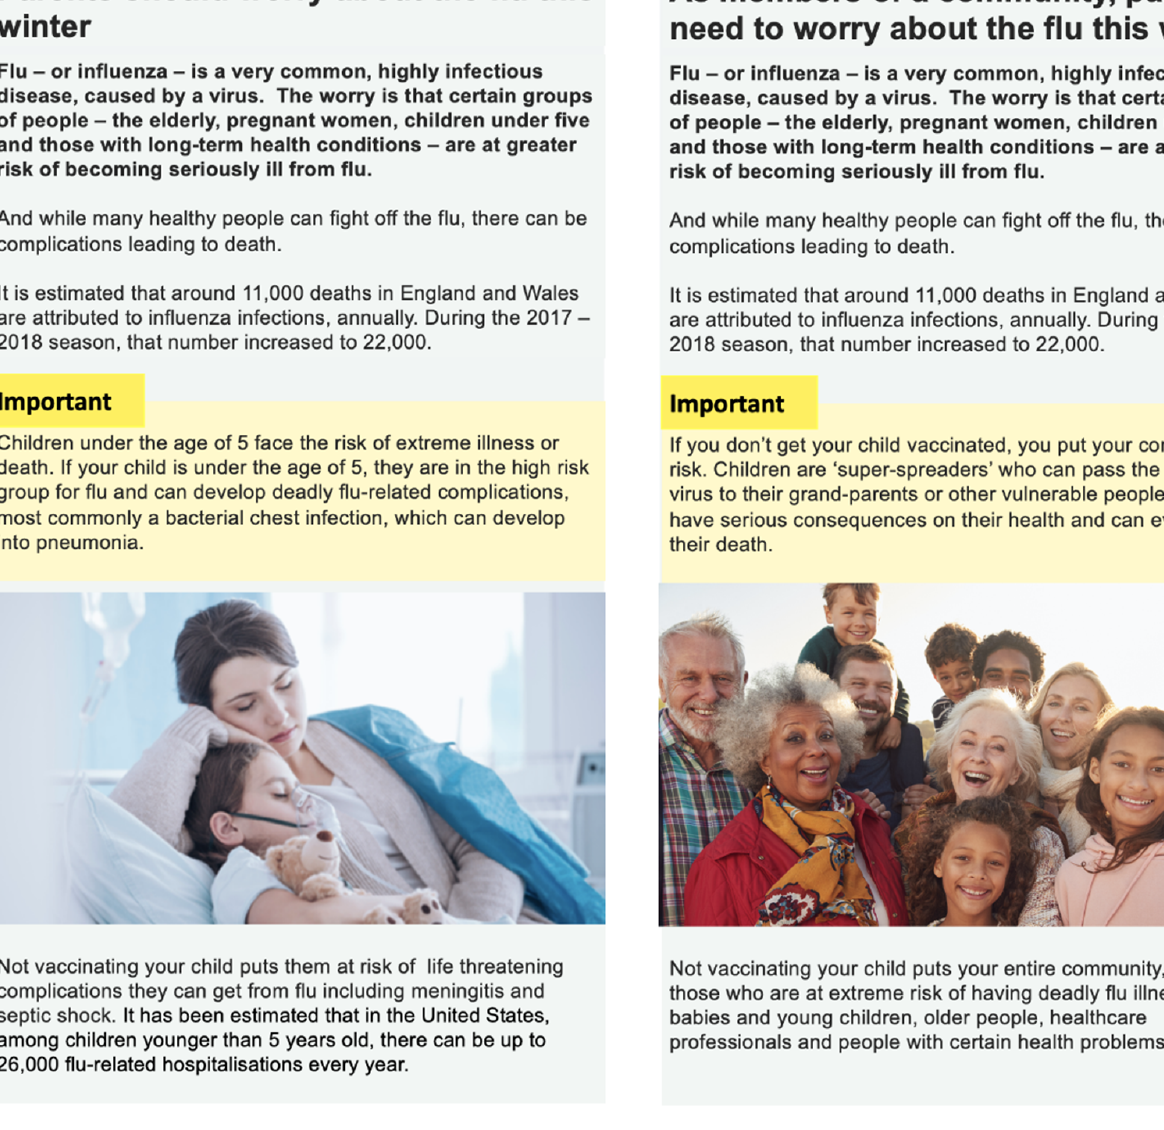
Figure 2. Schematic display of two of the NHS-like articles: flu with risks to child ( left ) and flu with risks to the community ( right ).